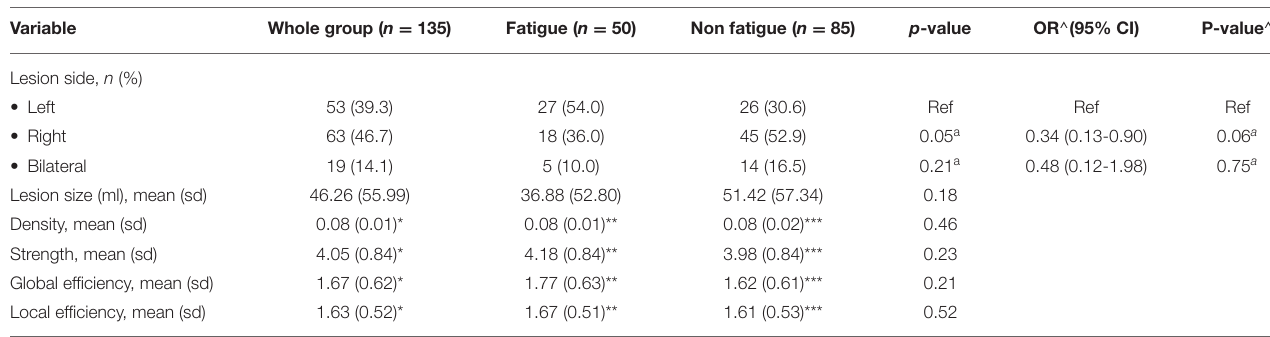
TABLE 2 | MRI variables of fatigued and no fatigue young stroke